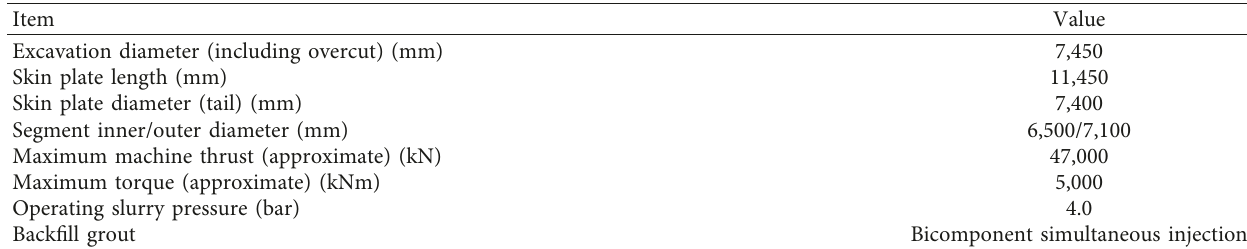
Table 2: Main specification of the